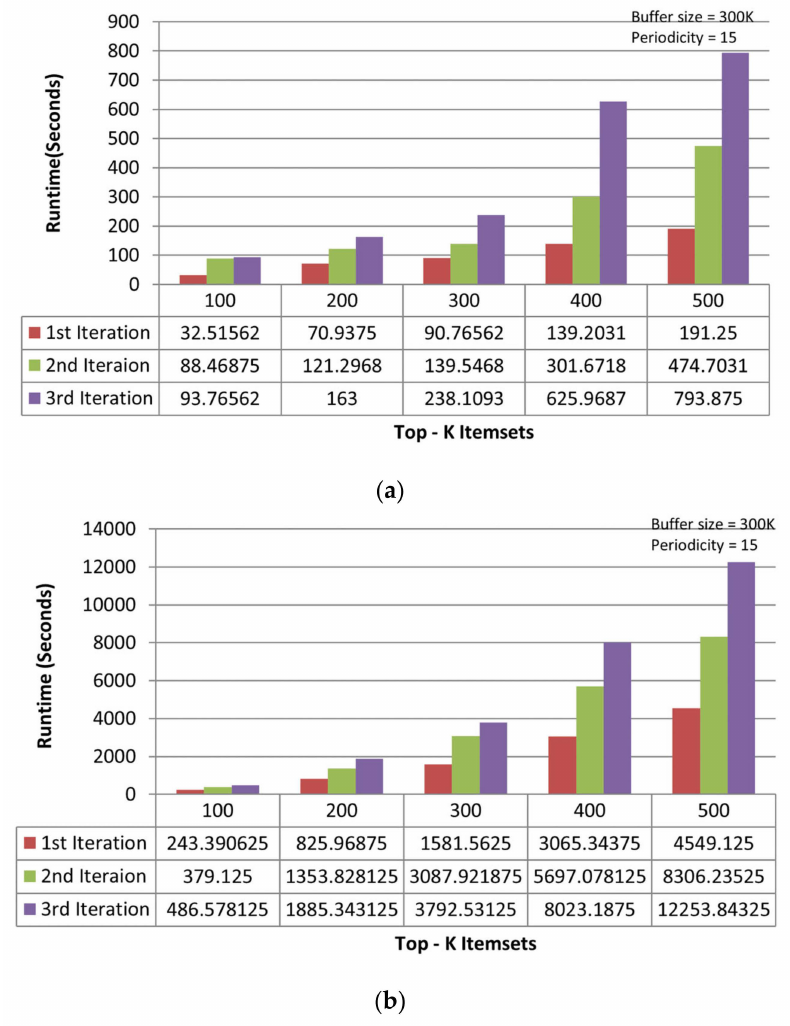
Figure 7. ( a ) Results of three iterations of TKIFRPM on the accident dataset. ( b ) Results of three iterations of MTKPP on the accident